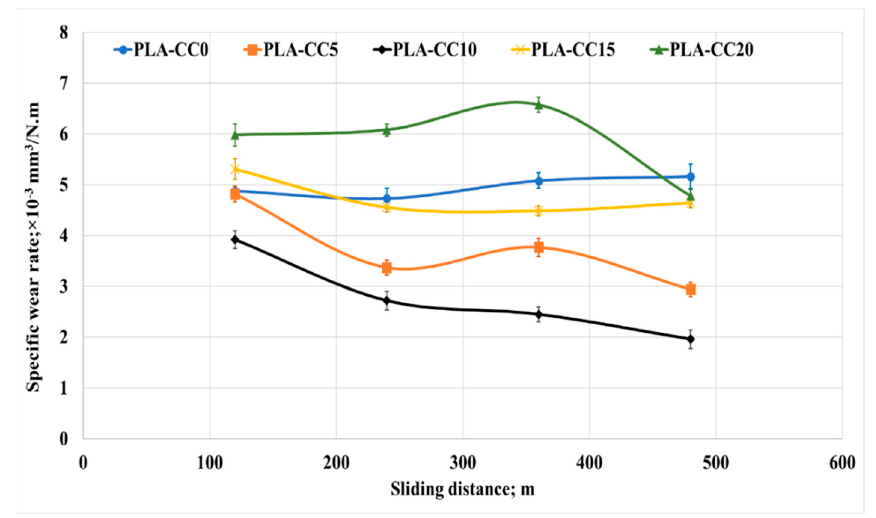
Figure 18. Specific wear rate of PLA-CC composites under different sliding distances.